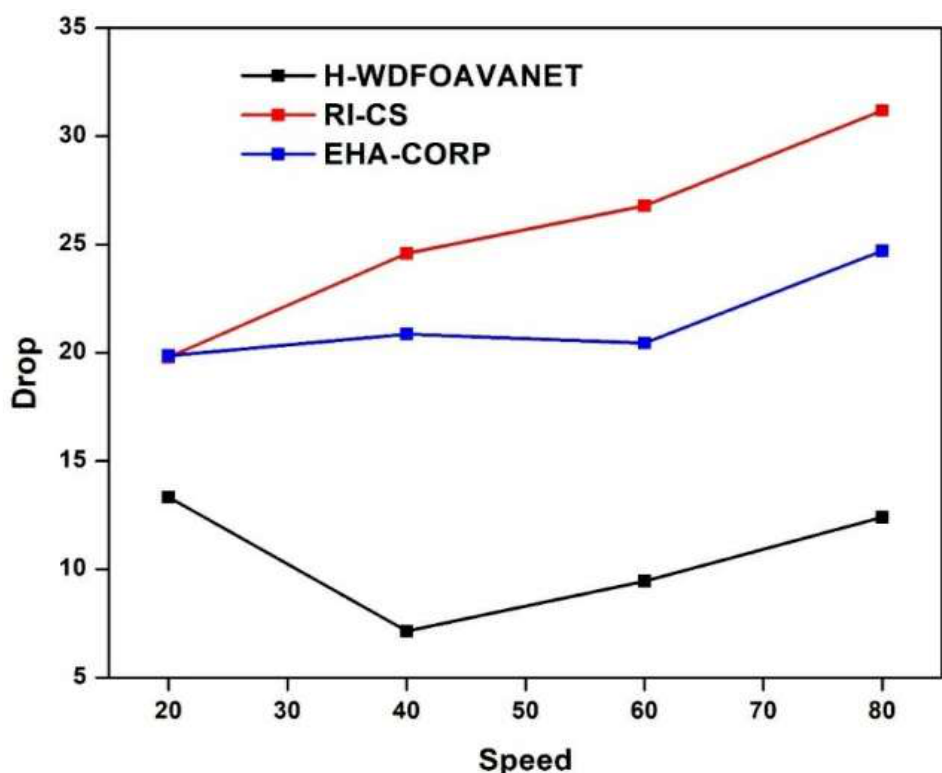
Figure 21. Plots of speed vs. energy consumption in the suggested approach and existing ap- proaches.